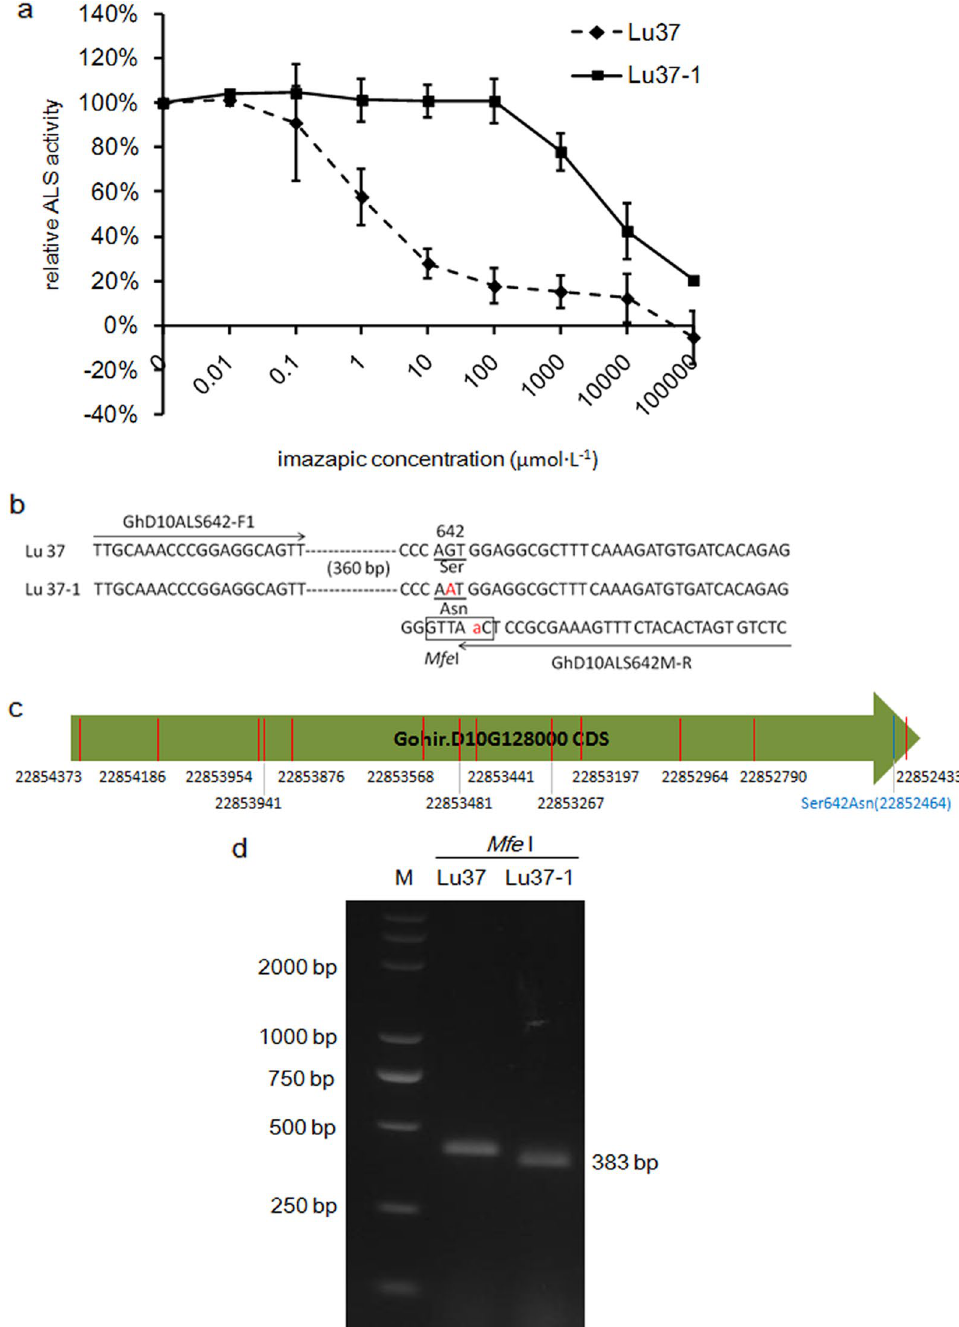
kanamycin to generate T 3 seeds. The T 3 plantlets as well as the wild-type Col were sown on the 1/2 MS supple- mented with 0 2 μmol L − 1 imazapic. At 21 DAT, the ∼ · wild-type Col and some transgenic lines showed a chlo- rosis phenotype on 0.1 μmol L − 1 imazapic plate, while · the resistant transgenic lines showed green leaves